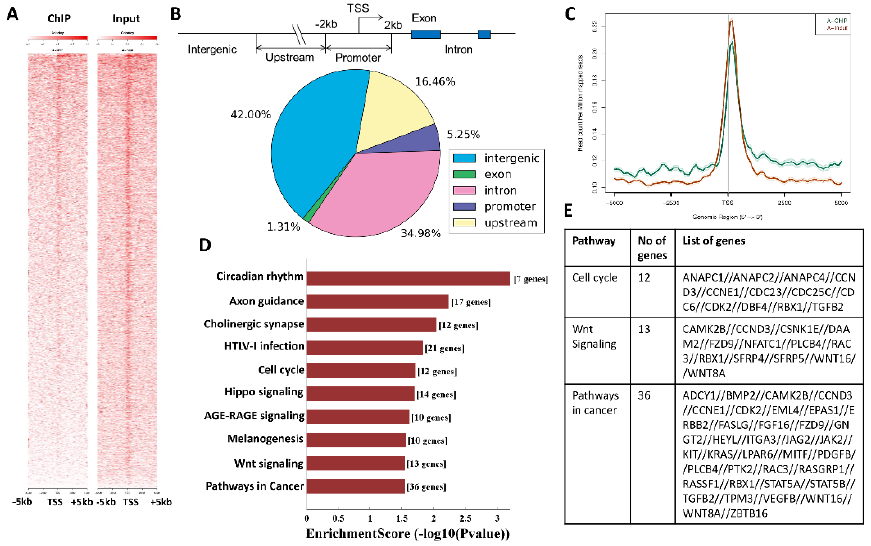
Figure 4. Chromatin immunoprecipitation (ChIP) analysis of transcriptomic and genome-wide SMYD3 binding profiles in MB. ( A ) Heat map showing the distribution and peak intensity of SMYD3 genomic occupancy from 5 kb downstream to 5 kb upstream. ( B ) Schematic representation of peaks into promoter peaks, upstream peaks, intron peaks, exon peaks, and intergenic peaks; pie diagram showing the distribution of peaks. ( C ) Graph depicting the ChIP peak at the global TSS (green) vs. Input peak (orange). ( D ) Pathway analysis using the Kyoto Encyclopedia of Genes and Genomes (KEGG) database showing SMYD3 enrichment scores. ( E ) List of genes and their representative pathways whose promoters were bound by SMYD3, as predicted by KEGG pathway analysis.